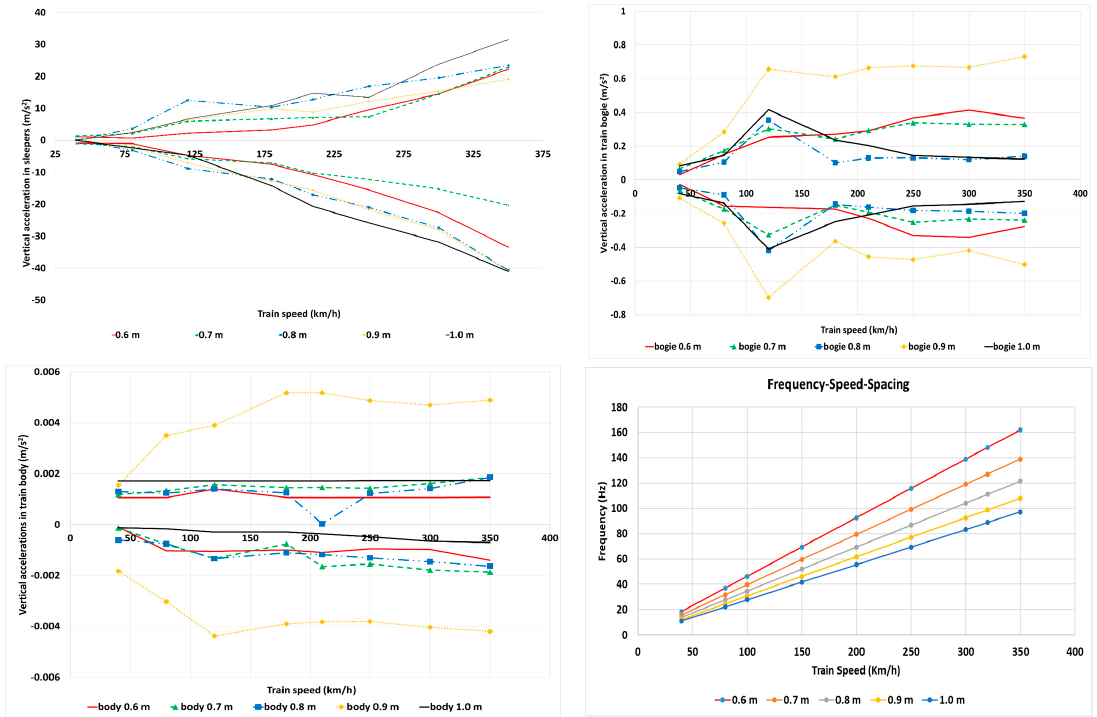
Figure 4. Case 2. Maximum and minimum vertical accelerations in the sleepers ( up, left ), in the bogie ( up, right ), and in the train ( down ) for the speeds studied and the defined spacings. Frequency with train speed and sleeper spacing variation ( down, right ). Vertical accelerations in the train (bogies and body) seems not to vary greatly when increasing the train speed. However, the vertical accelerations in sleepers increase with the train speed. This increase follows an almost a linear variation from 50 km/h onwards for all analysed sleeper distances. As presented before, the limits in the literature vary from 10 to 100 m/s 2 , so considering an average value, it allows for sleeper spacings of 1.0 m. However, this is the most restrictive variable for the ones presented in Error! Reference source not found. . The simulation time is enough, and as can be seen in Figure 4, the initial disturbances were stabilized in a steady state solution (train bogie and body). The track irregularities have not been considered in the analysis’ vertical accelerations, and this is the main reason why the obtained values are low, but indicative for the trend of the vertical accelerations. 3.3. Case 3. Rail Type Two commonly used rails in Spain are used in the simulation, namely UIC 54 (54 kg per lineal metre) and UIC 60 (60 kg per lineal metre). High-speed railways use UIC 60 nowadays, and the UIC 54 rail is disappearing in most conventional tracks. Only narrow- gauge tracks in Spain keep this type of rail. Figure 5 shows the vertical displacements in the sleepers and rails, as well as the forces and stresses for the two considered types of rails. The differences between both types of rails are negligible, as, for example, the shear force on the rail, which increases when the distance between the sleepers increases, and as expected, the lighter rail suffers more. In the same way, the stresses transmitted to the ballast are lower when using the UIC 60 rail (heavier rails). The vertical displacements of